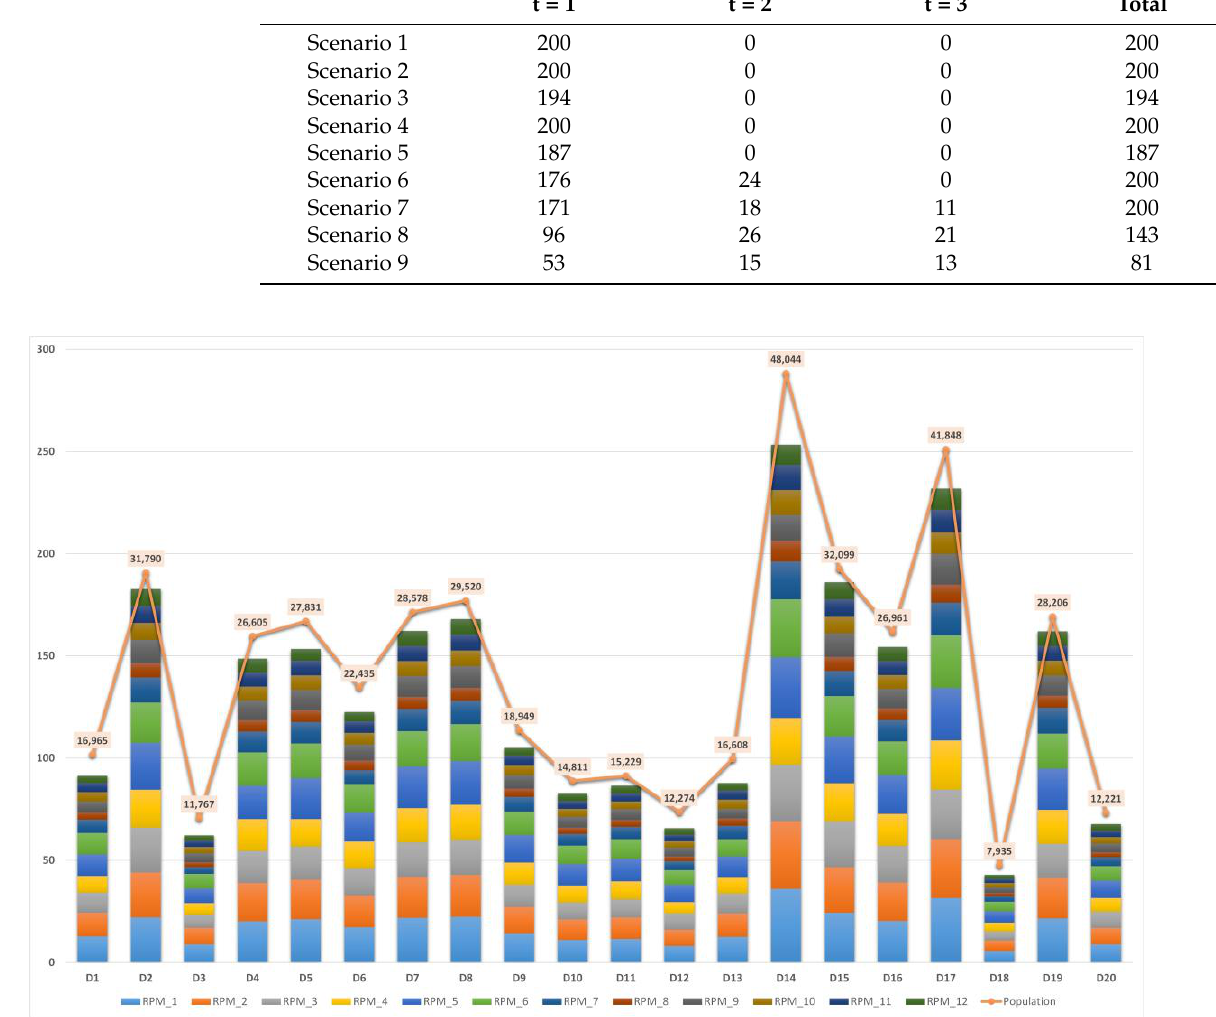
Figure 5. The number of transported casualties based on RPM score at demand points at the 26th solution.